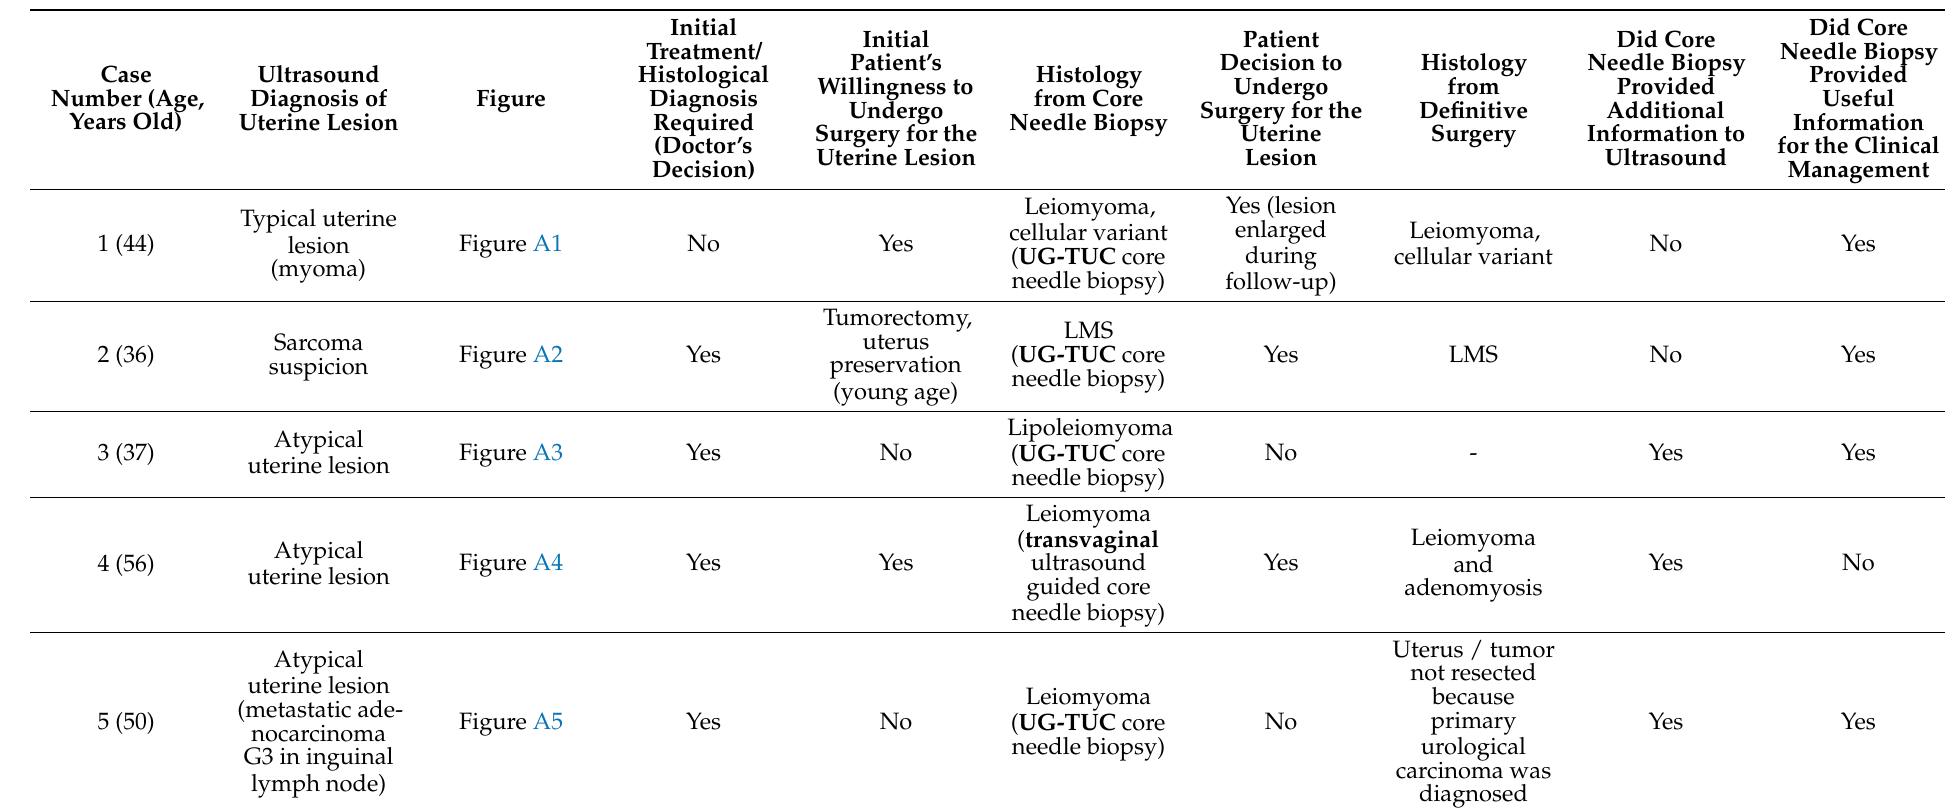
Table A1. Case series where ultrasonography of uterine lesions was supplemented by core needle biopsy. Clinical, sonological and histological data are provided, together with clinical significance of addition of core needle biopsy to